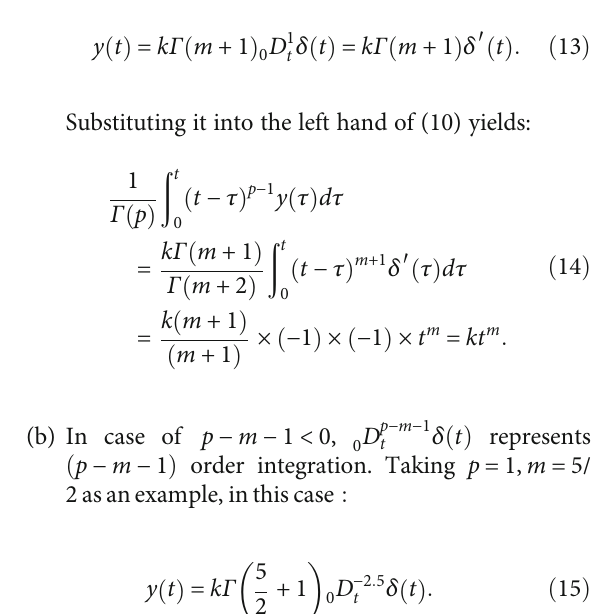
Figure 1 plots the curve of y ð t Þ with k = 2